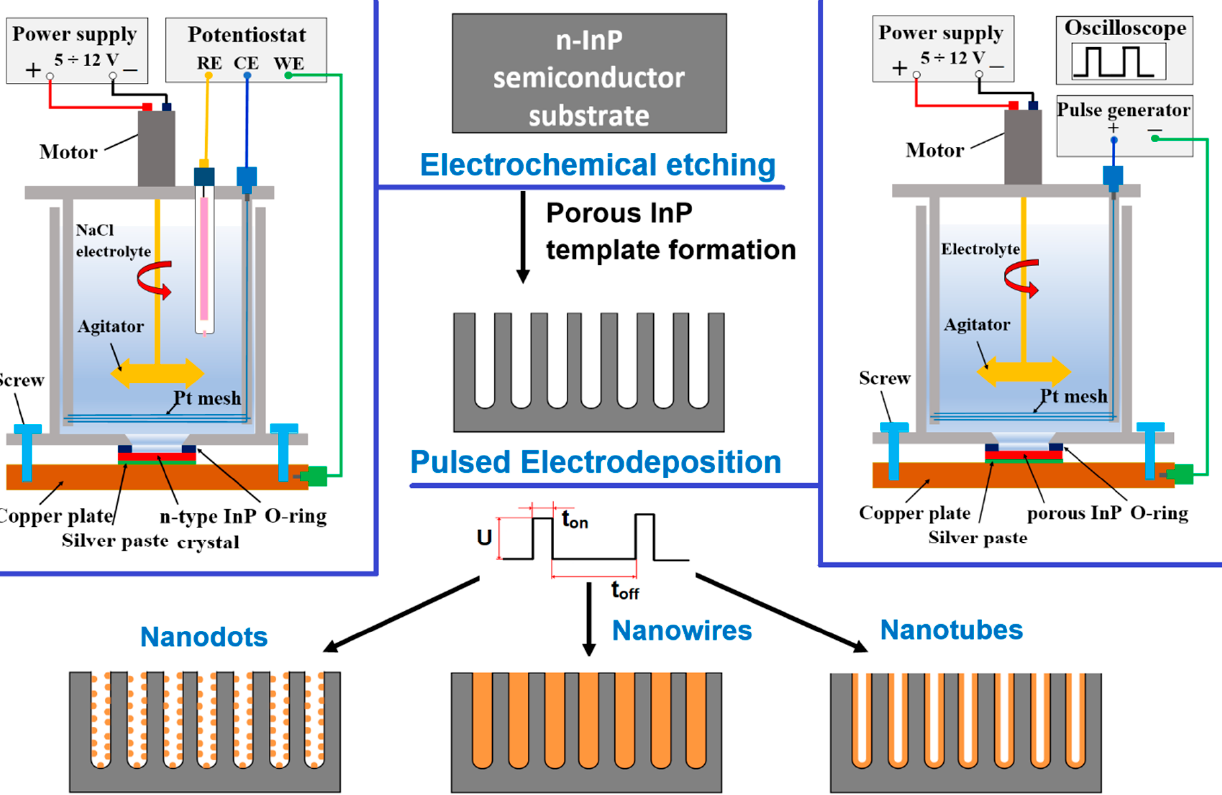
Figure 1. Schematic representation of the set-up for electrochemical etching of semiconductor sub- strates as well as pulsed electrochemical deposition of metal nanostructures in porous semiconductor templates. The technological work-flow is presented for InP crystals.